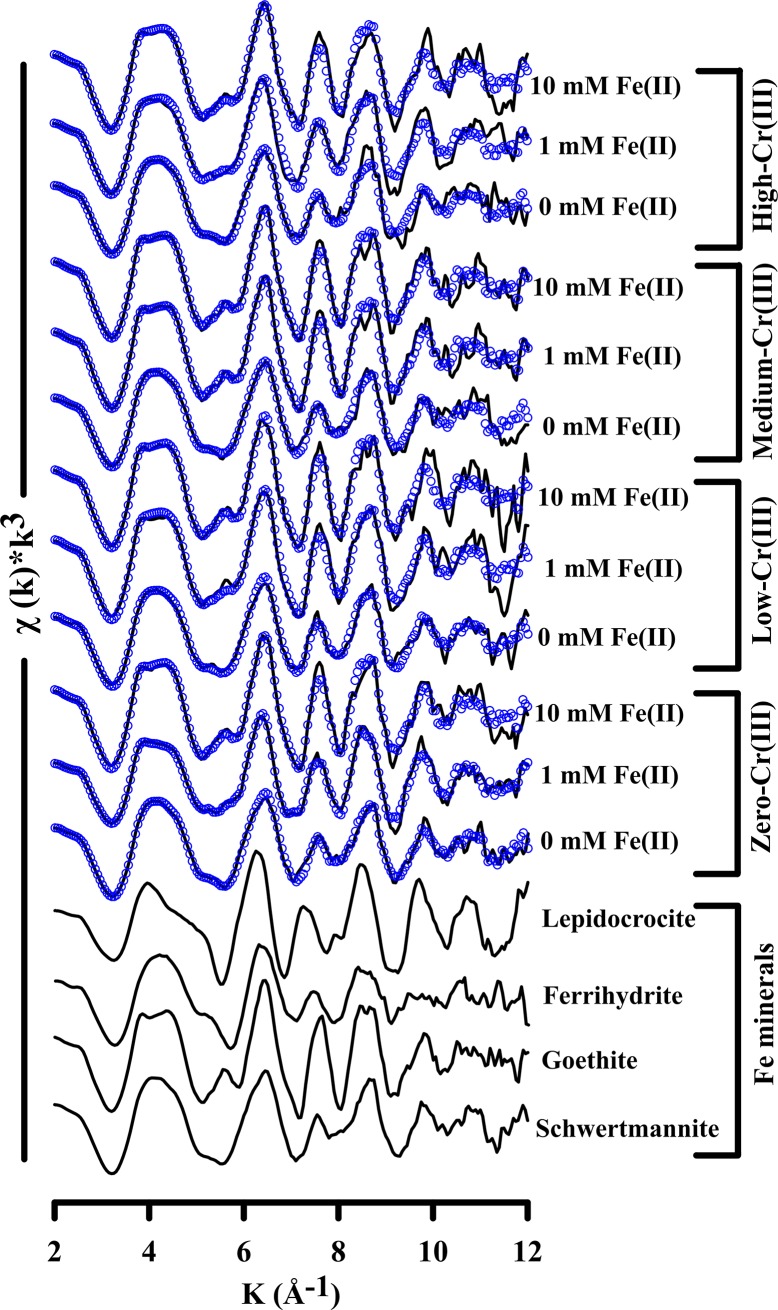
Iron K-edge EXAFS spectra of Cr(III)-free and Cr(III)-incorporated schwertmannite and their mineralogical transformation during Fe(II) accelerated transformation at reaction period of 14 days.The XAS data of the samples are shown as a solid line and the linear combination fit is shown as coloured circles.